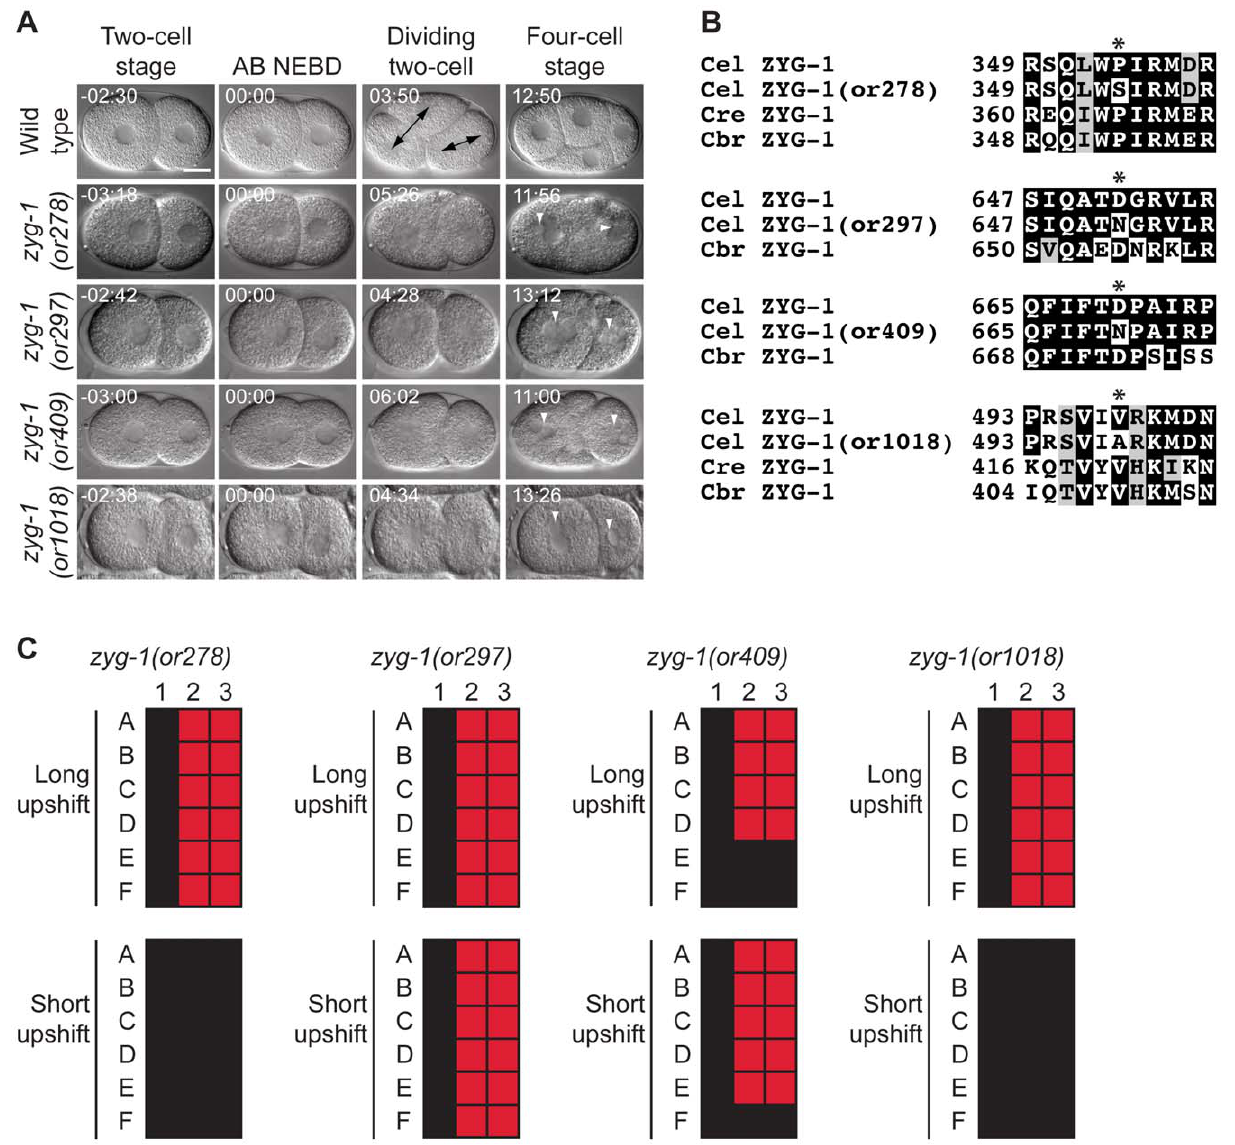
Figure 7. zyg-1 mutants. A. DIC time-lapse images of wild-type, zyg-1(or278 ts ) , zyg-1(or297 ts ) , zyg-1(or409 ts ) , and zyg-1(or1018 ts ) embryos. In the zyg-1 mutants the two cell stage blastomeres assembled monopolar spindles, cytokinesis failed, and there were multiple nuclei present at the four cell equivilent stage. The zyg-1(or278 ts ) , zyg-1(or409 ts ) , and zyg-1(or1018 ts ) embryos were obtained from hermaphrodites shifted to the restrictive temperature for 5–6 hours. The zyg-1(or297 ts ) embryo was obtained from a hermaphrodite shifted to the restrictive temperature for 30 minutes prior to imaging. Black arrows indicate normal bipolar spindles in the wild-type embryo and white arrowheads indicate multiple nuclei present at the four cell equivalent stage. Times in min:sec are given relative to AB nuclear envelope breakdown (NEBD). Scale bar, 10 m m. B. Amino acid alterations in the mutants. Asterisks indicate the changed residues. Homologous proteins are aligned below the C. elegans protein. C. Defect maps for the zyg-1 mutants.Individual embryos observed during time-lapse recordings: embryos are listed on the left and phenotypes are listed on the top: 1; normal two cell embryo, 2; bipolar spindles at two cell stage, 3; one nucleus per cell at four cell stage. In the long upshifts, hermaphrodites were transferred to the restrictive temperature for 5–8 hours. In the short upshifts, embryos were harvested from hermaphrodites grown at the restrictive temperature for 30 minutes.